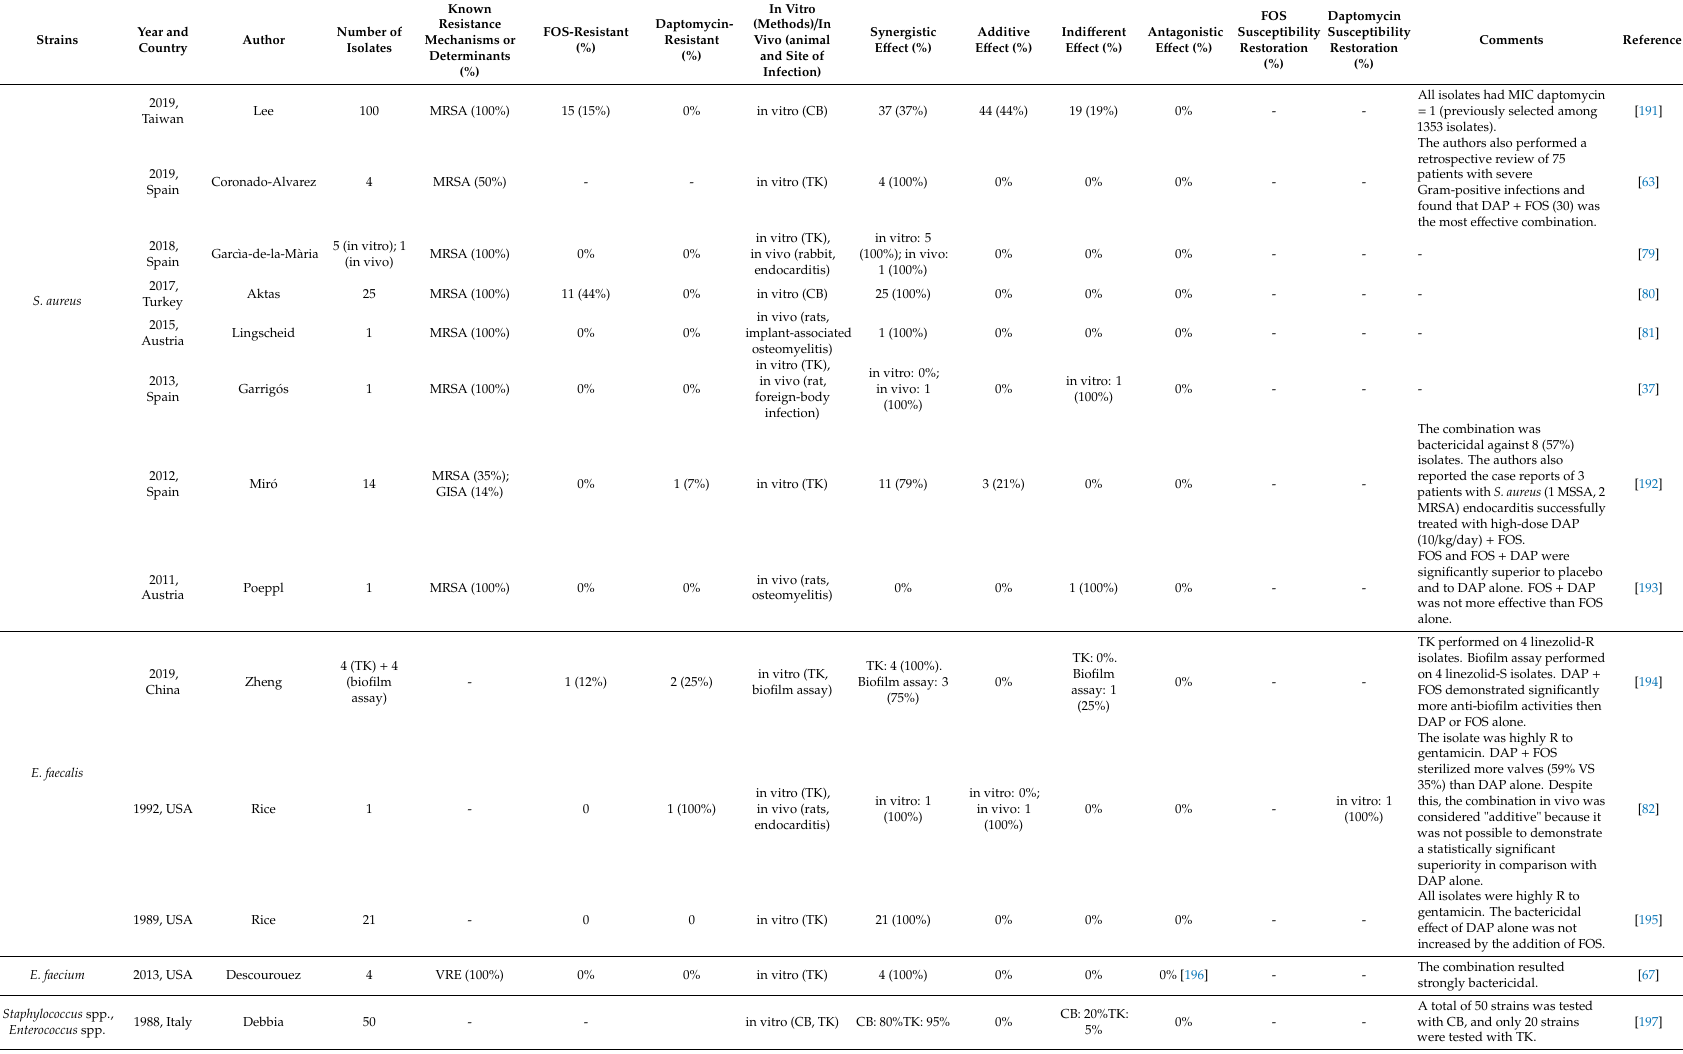
Table 11. Studies on combination between fosfomycin and daptomycin. CB: checkerboard assay; TK: time–kill assay; ET: E-test. Strains